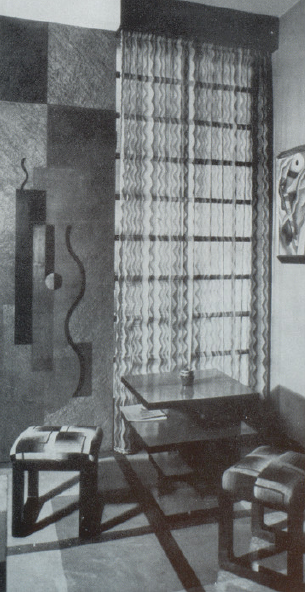
Figure 5. Nicolaj Diulgheroff, Jacobacci apartment in Turin with curtains made by the A. Borghi company, 1930. Photo from (Paulucci 1931). In public domain.